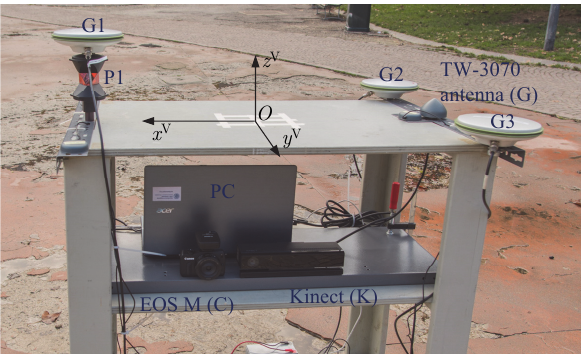
Figure 1. Cart setup. The instruments mounted on-board and the materialized vehicle reference frame V are highlighted. The photo was taken during the calibration